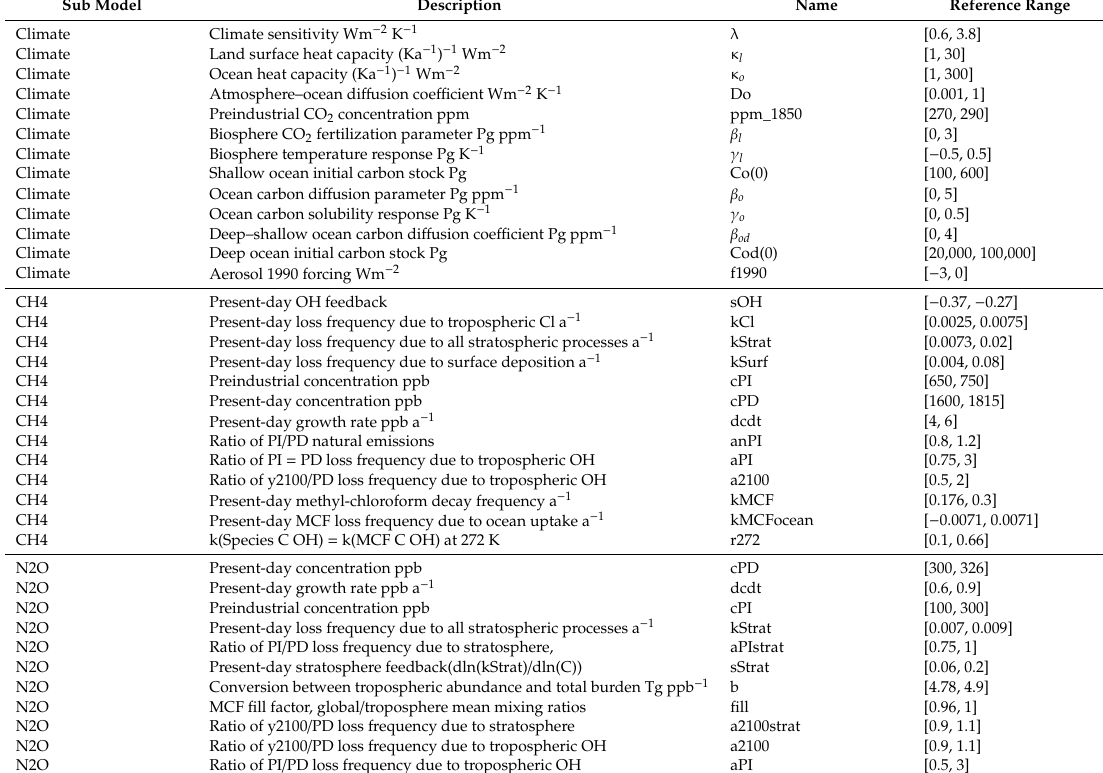
Table A1. Parameter ranges for the MiCES model used in this